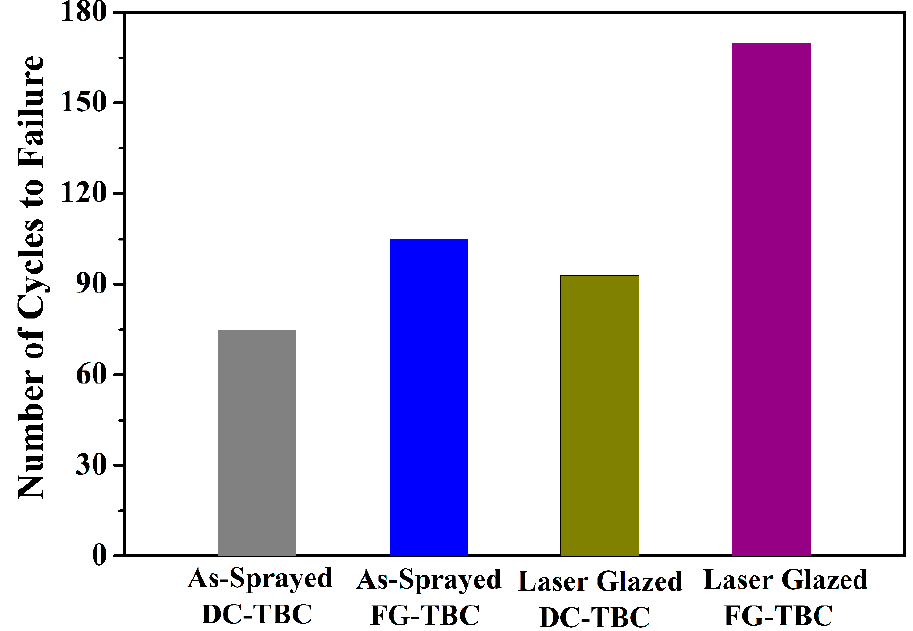
Figure 10. Thermal shock resistance, i.e., number of cycles to failure of DC-TBC and FG-TBC coatings in their as-sprayed and laser-glazed conditions. and laser-glazed